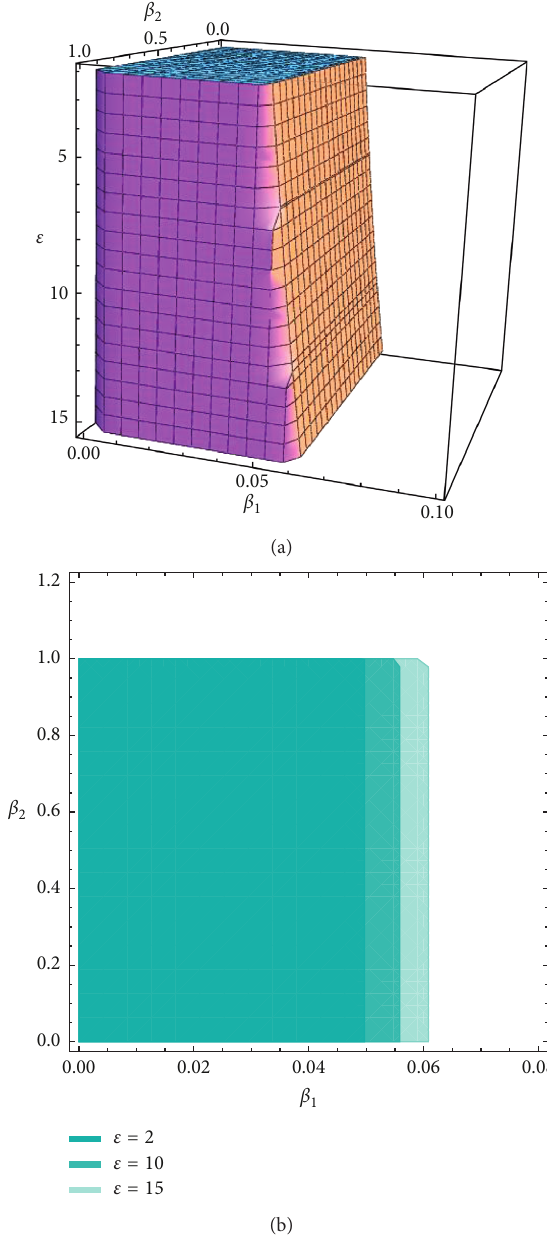
Figure 29: Stable region with respect to β region. (b) 2D stable region in the ( β Table 3: 2D stable region with respect tos and ε in the ( β